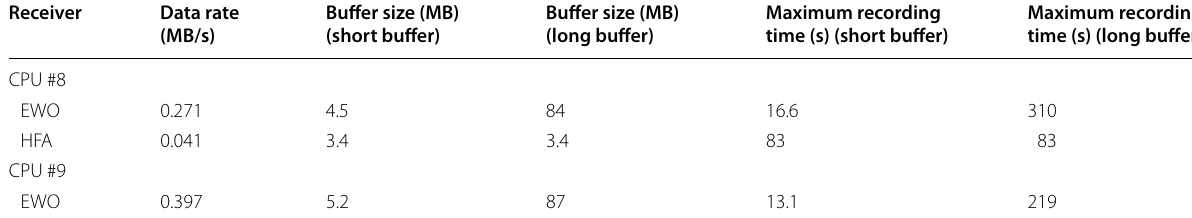
Table 2 Configuration of the long buffer and the short buffer on the CPUs Receiver